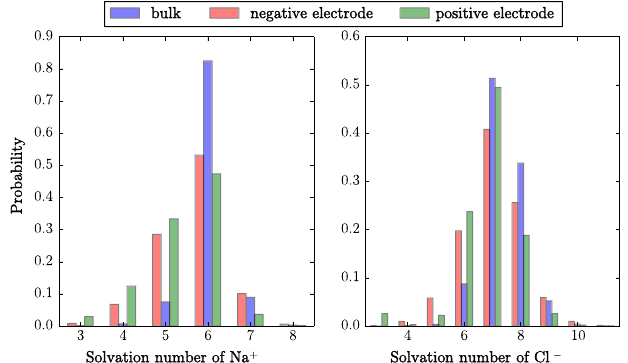
FIG. 4. Distribution of solvation number for Na þ (left panel) and Cl − (right panel) ions in the bulk, negative and positive electrodes, for the 1.0 M system.